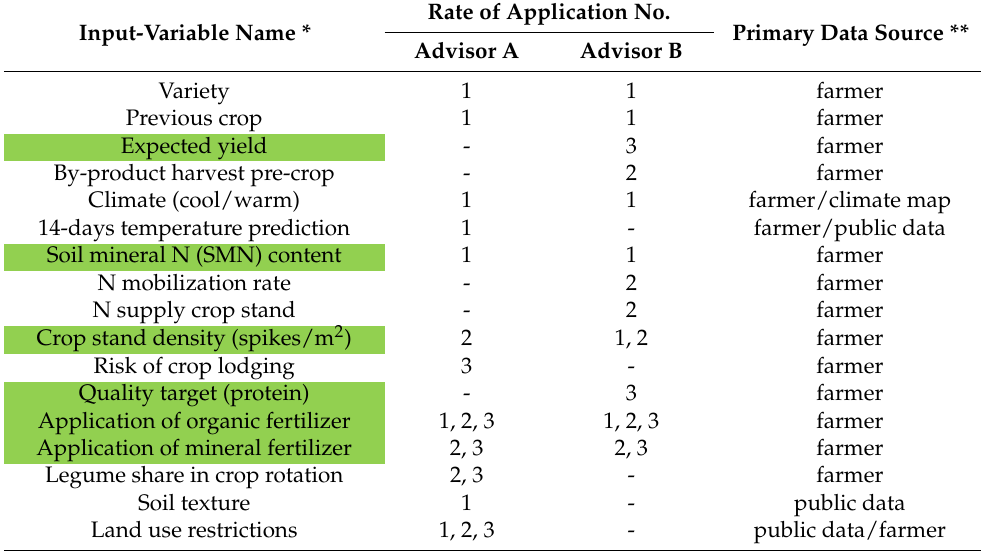
Table 1. Parameters of the decision trees for specifying the 1st, 2nd and 3rd rate of N